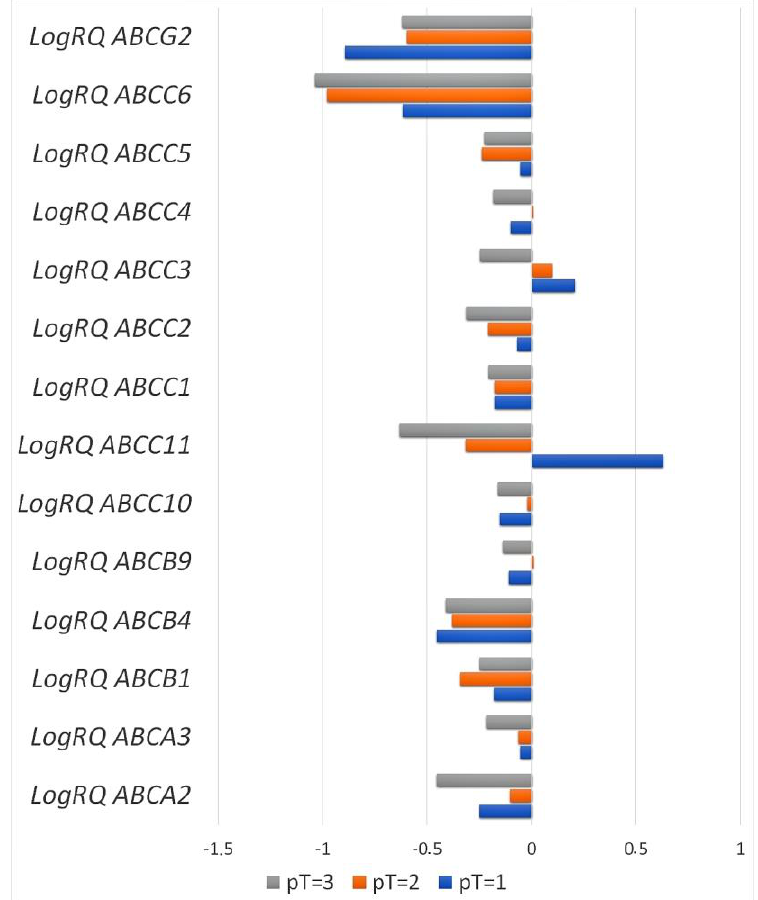
Figure 9. The average expression level of the tested genes from the ABC family in patients classified into the T1, T2, or T3 groups, depending on the size of the primary tumor (T1—patients with a primary tumor size ≤ 20 mm, T2—patients with a primary tumor size > 20 mm but ≤ 50 mm, and T3—patients with a primary tumor size greater than 50 mm). Table 3. Descriptive statistics including the level of significance of the difference in the expression of the studied genes in three groups of patients distinguished on the basis of the size of the primary tumor (the H Kruskal–Wallis test with multiple comparison). Statistically significant values are marked with *.